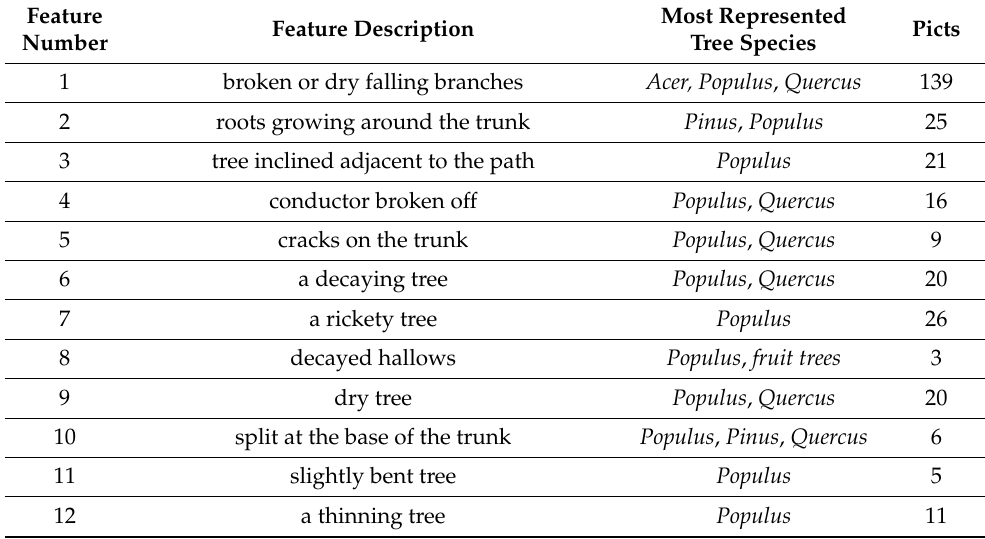
Table 2. List of features of poor health condition of trees observed in Biela´nski Forest and Kabacki